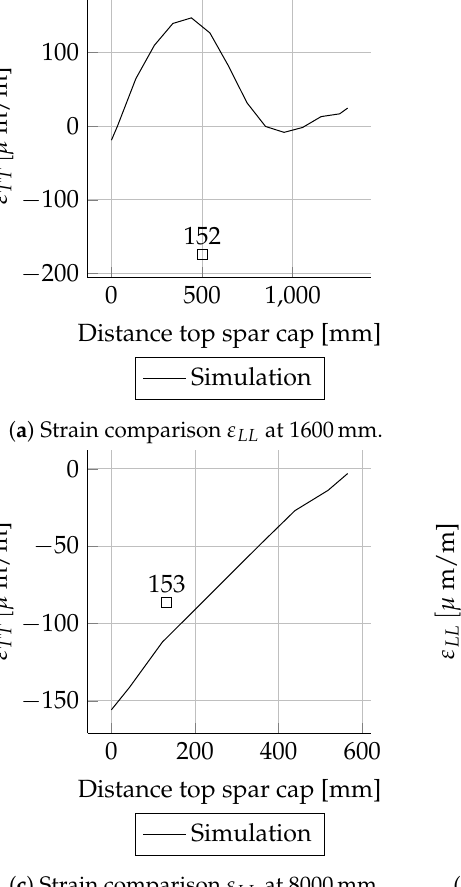
( a ) Strain comparison ε LL at 1600mm. ( b ) Strain comparison ε TT at 1600mm.